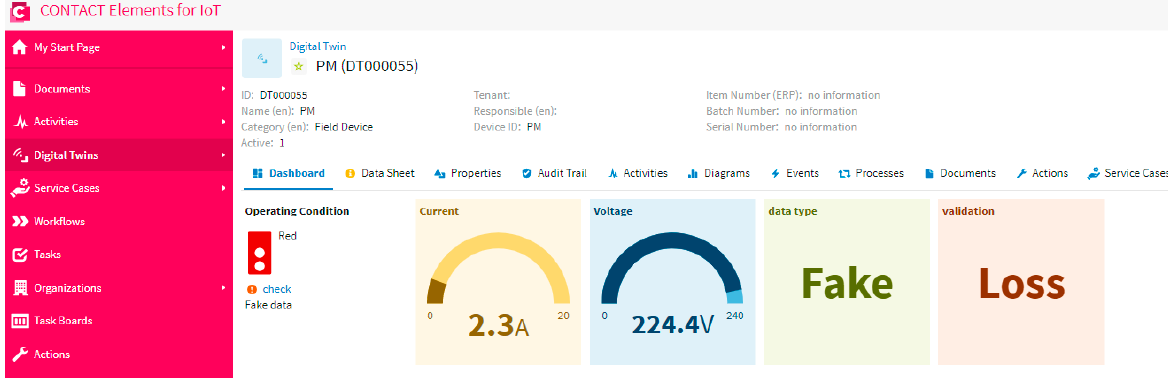
Figure 13. The dashboard of the IoT platform results in a case of testing the fake data and internet capability.